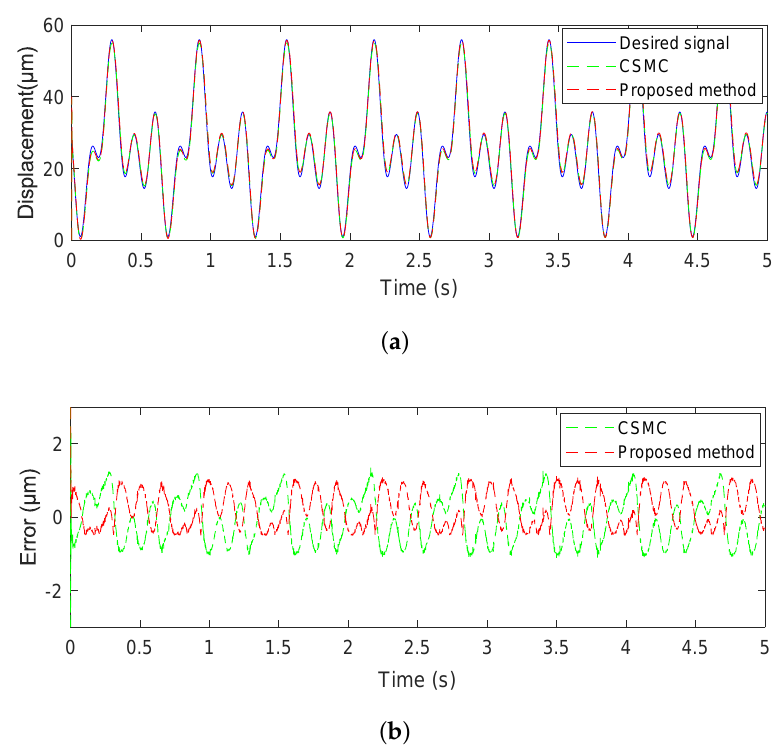
Figure 11. Comparative results of the piezoelectric actuated stage with the complex wave signal. ( a ) tracking curve of the piezoelectric actuated stage; ( b ) tracking